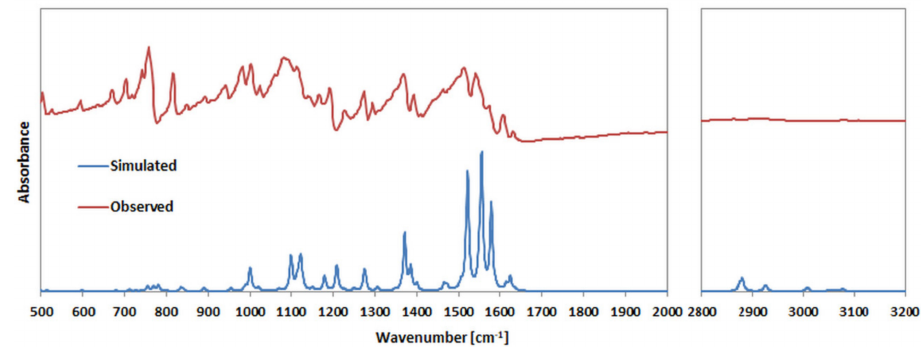
Figure 8. Comparison of the observed with simulated (scaled) IR absorption spectra of 2-(4-dimethylamino)benzoylbenzoxazole difluoroborane ( 1 ) in the region 500–2000 cm − 1 and 2800–3200 cm − 1